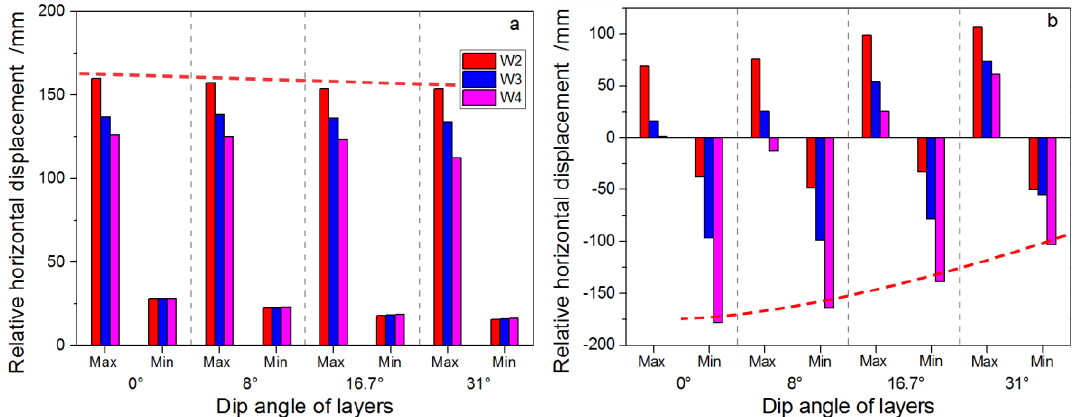
Figure 8. Extreme value statistics of relative horizontal displacement of hydrocarbon wells after the ( a ) first panel is removed and then ( b ) the second panel is removed for various SDAs.